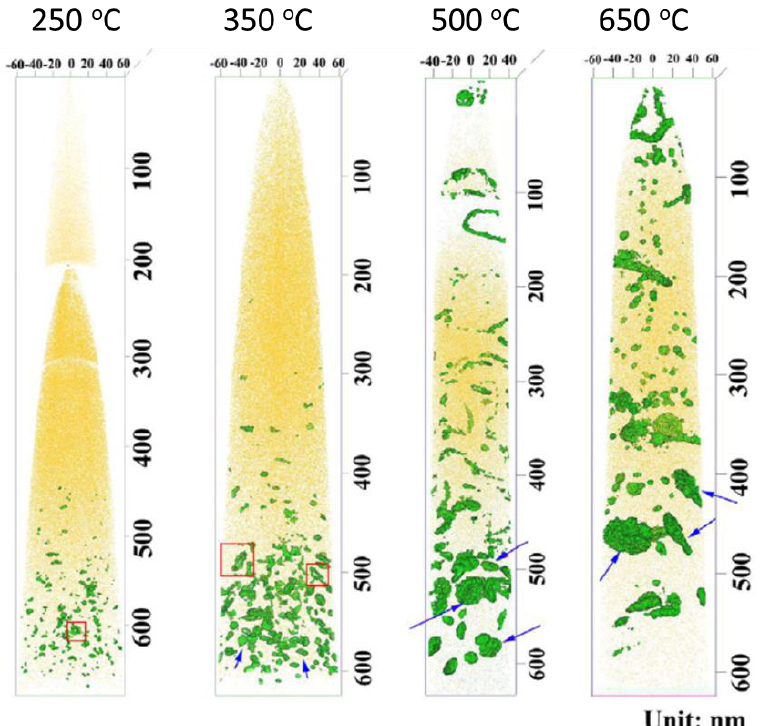
Figure 5. The dislocation loops in Al 0.1 CoCrFeNi CCA when irradiated under 3 Mev Au ion beam at 250, 350, 500 and 650 °C is characterized by atom probe tomography (APT). The size and density of dislocation loops grows with the irradiation temperature, reprinted with permission from Ref.